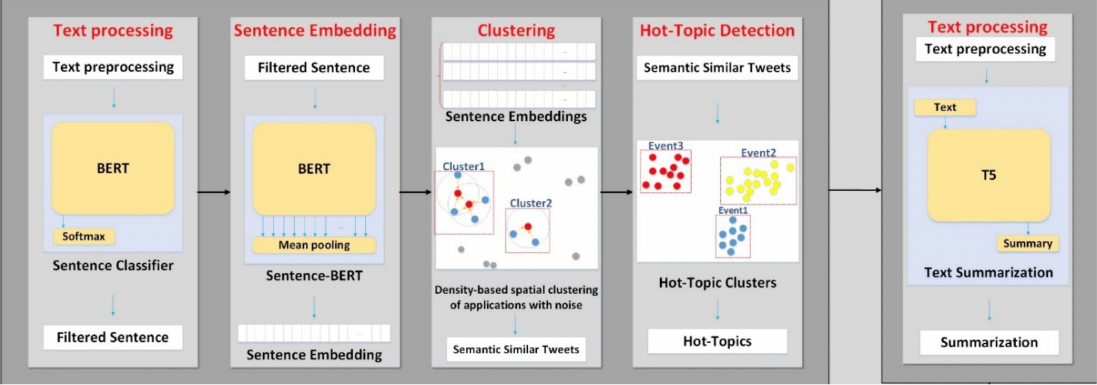
Figure 2. Developed text summarization method using a hybrid pre-trained model